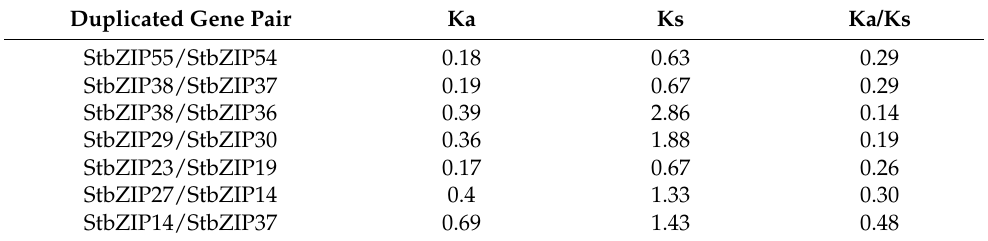
Table 2. The nonsynonymous (Ka) and synonymous (Ks) substitution ratio (Ka/Ks) test for 22 gene pairs.